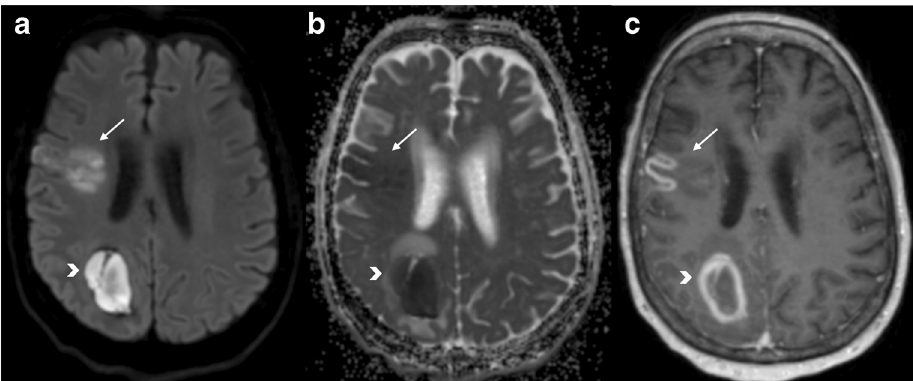
Fig. 9 Subacute haematoma. Right parietal mass (arrowhead) showing diffusion restriction within the core on DWI and ADC maps ( a and b , respectively) and a ring-enhancing pattern on T1 post gadolinium ( c